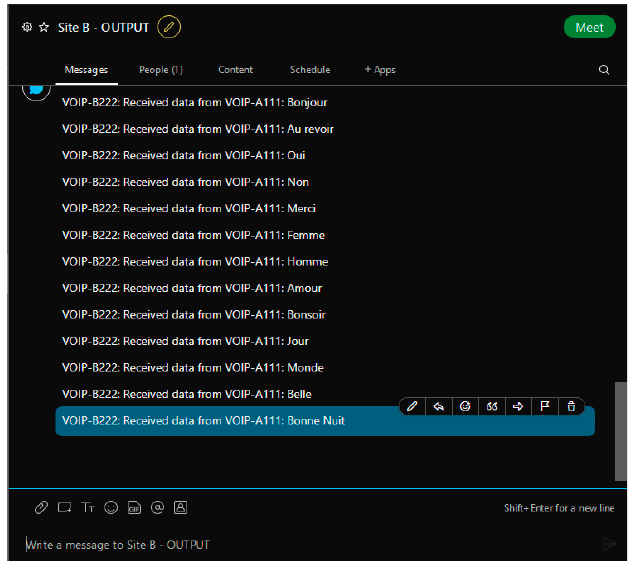
Figure 7. Cisco Webex output room.